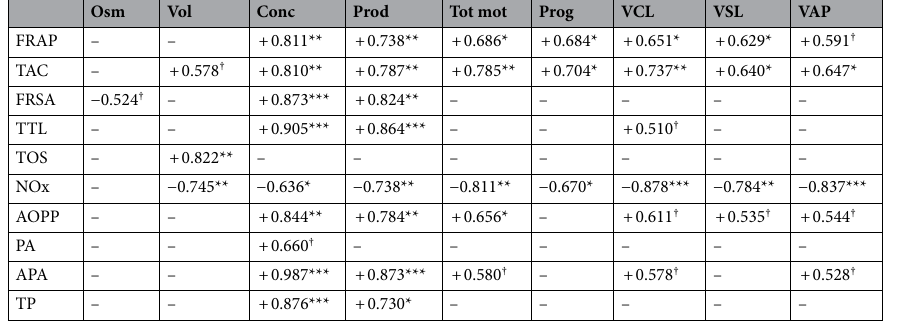
Table 4. Correlation matrix between oxidative profile and proteolysis regulator parameters in the seminal plasma, semen parameters and sperm kinetics in donkey stallions (n = 9). FRAP: ferric reducing ability of plasma; TAC: total antioxidant capacity; FRSA: free radical scavenging activity; TTL: total thiol levels; TOS: total oxidant status; NOx: nitric oxide metabolites; AOPP: advanced oxidation protein products; PA: protease activity; APA: antiprotease activity; TP: total protein; Osm: osmolarity; Vol: volume; Conc: sperm concentration; Prod: sperm production; Tot mot:total sperm motility; Prog: progressive sperm motility; VCL: curvilinear velocity; VSL: straight-line velocity; VAP: average path velocity. *, **, ***: indicate a statistic significance for P < 0.05; P < 0.01 and P < 0.001, respectively; † : indicate a tendency for P <